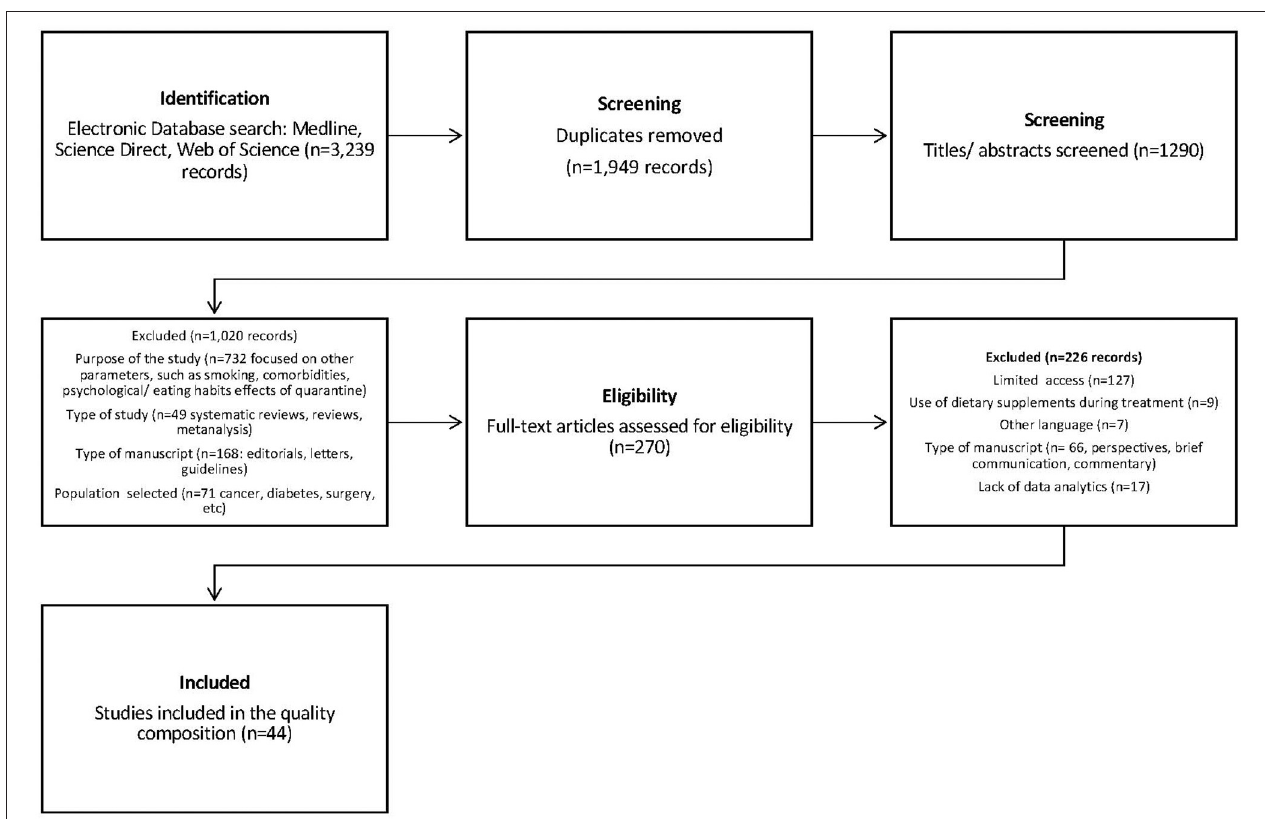
FIGURE 1 | Flow chart showing selection procedure for studies on obesity and COVID-19